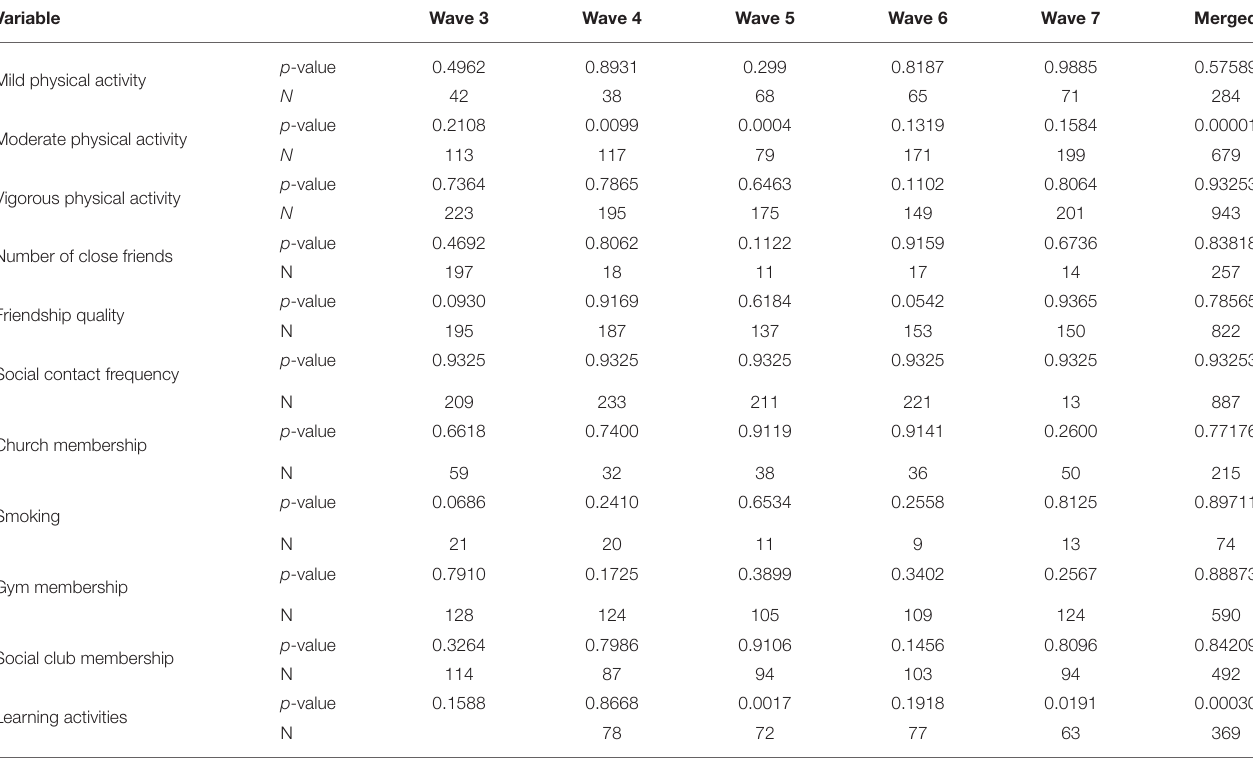
TABLE 2 | P -values and sample sizes associated with hypothesis testing across all waves and merged population.